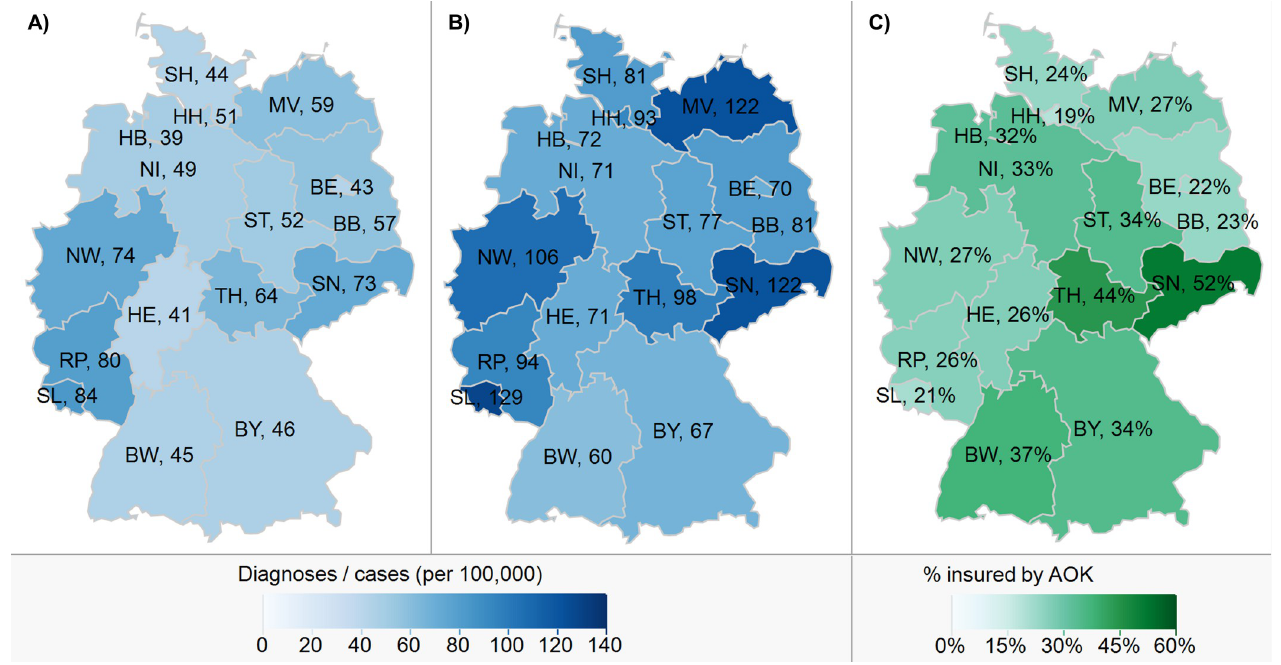
Fig 2. Comparison of Campylobacter enteritis rates between the Federal States of Germany in 2017. A) Campylobacter enteritis diagnoses per 100,000 AOK insurants in 2017. B) Officially reported Campylobacter enteritis cases per 100,000 inhabitants in Germany in 2017 according to national surveillance data [2]. C) Proportion of the population insured by AOK in 2017 according to the official statistics [22, 41]. Maps were created in JMP 16.2.0. BW: Baden- Wu¨rttemberg, BY: Bavaria, BE: Berlin, BB: Brandenburg, HB: Bremen, HH: Hamburg, HE: Hesse, MV: Mecklenburg-Western Pomerania, NI: Lower Saxony, NW: North Rhine-Westphalia, RP: Rhineland-Palatinate, SL: Saarland, SN: Saxony, ST: Saxony-Anhalt, SH: Schleswig-Holstein, TH: Thuringia.